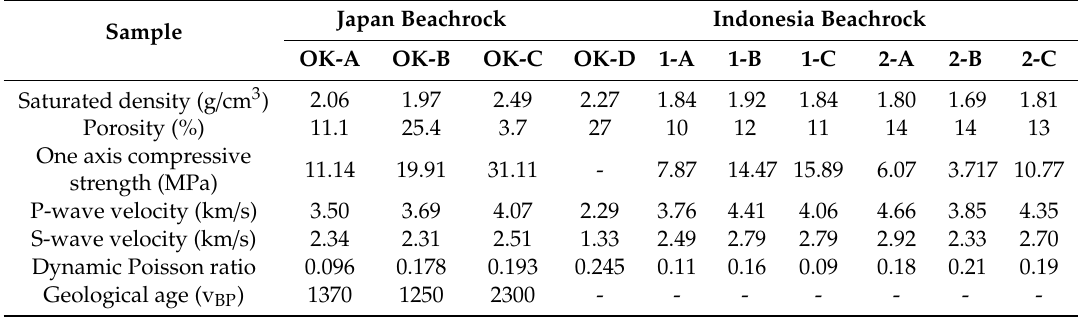
Table 1. Comparison of beachrock properties between Japan and